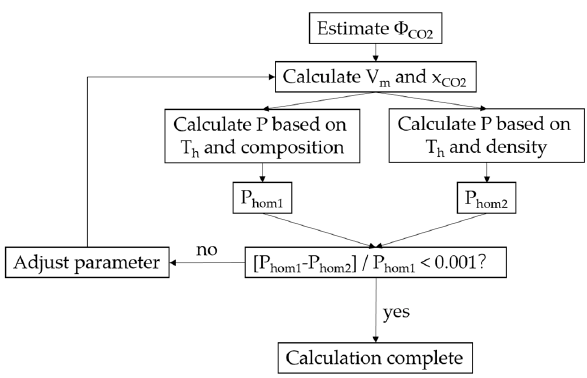
Figure 1. Flowchart for the calculation of V-x properties of two-phase CO 2 –H 2 O–NaCl fluid inclusions.